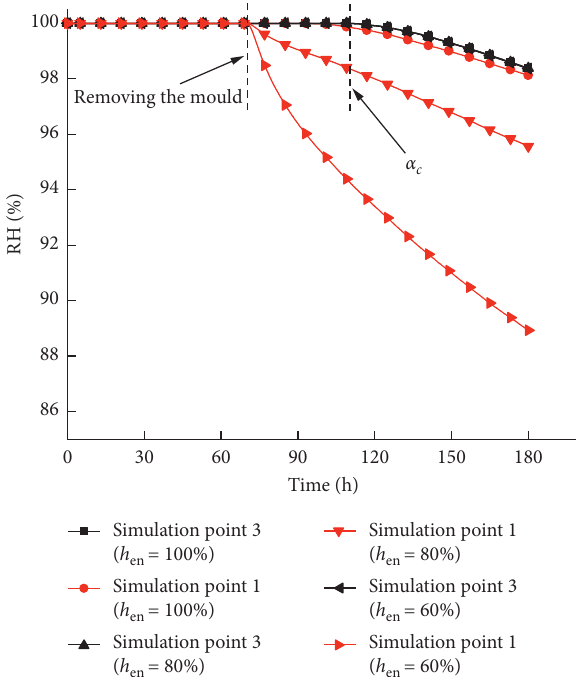
Figure 16: Comparison of simulated data on points 1 and